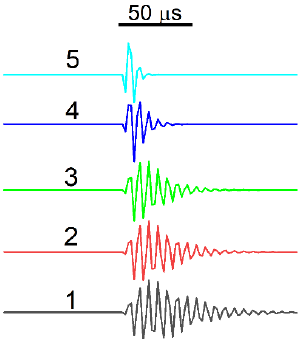
× 10 10 N s −1 and b = 1.0 × 10 5 s −1 .